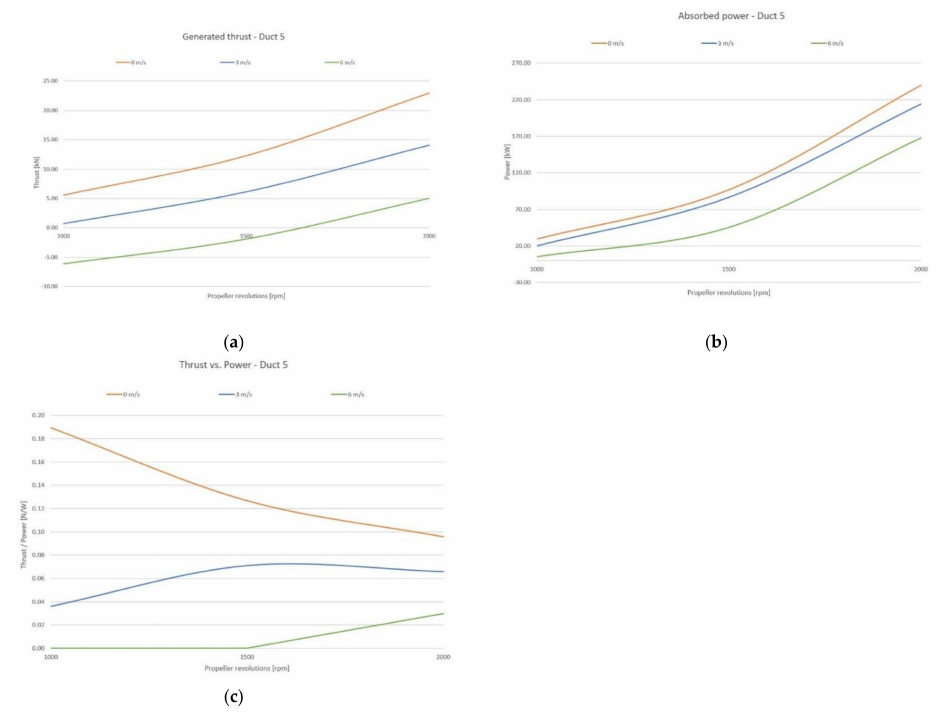
Figure 12. Performance characteristics of propeller with Duct 5. ( a ) Generated thrust for different speeds depending on the propeller speed; ( b ) absorbed power for different speeds depending on propeller speed; ( c ) generated thrust per unit of power